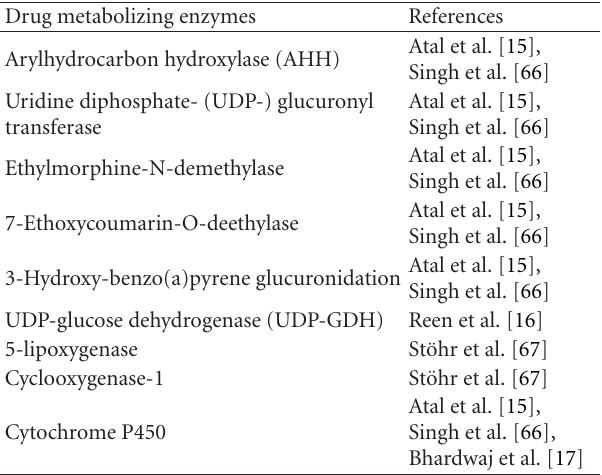
Table 2: Drug metabolizing enzymes inhibited by piperine. Drug metabolizing